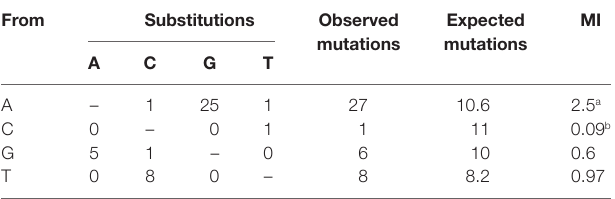
TaBle 3 | Substitutions and mutability index (MI) of T cell receptor (TCR) C α mononucleotides. From substitutions Observed